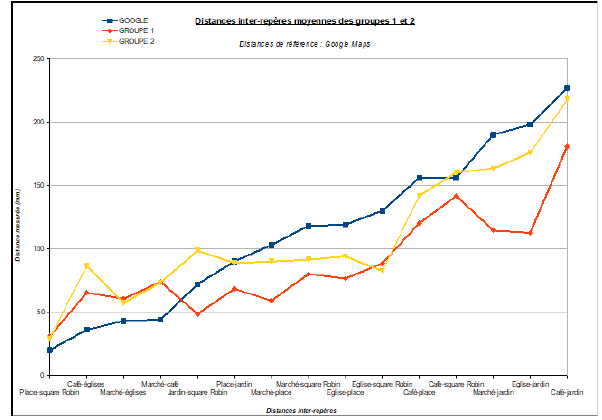
Figure 16. Graph of the correlation between geographical distances in Google Map, group 1 & 2. Correlation Google distances / group 1 = 0.92, Google distances / group 2 = 0.87. Blue = Google, red = group 1, violet = group